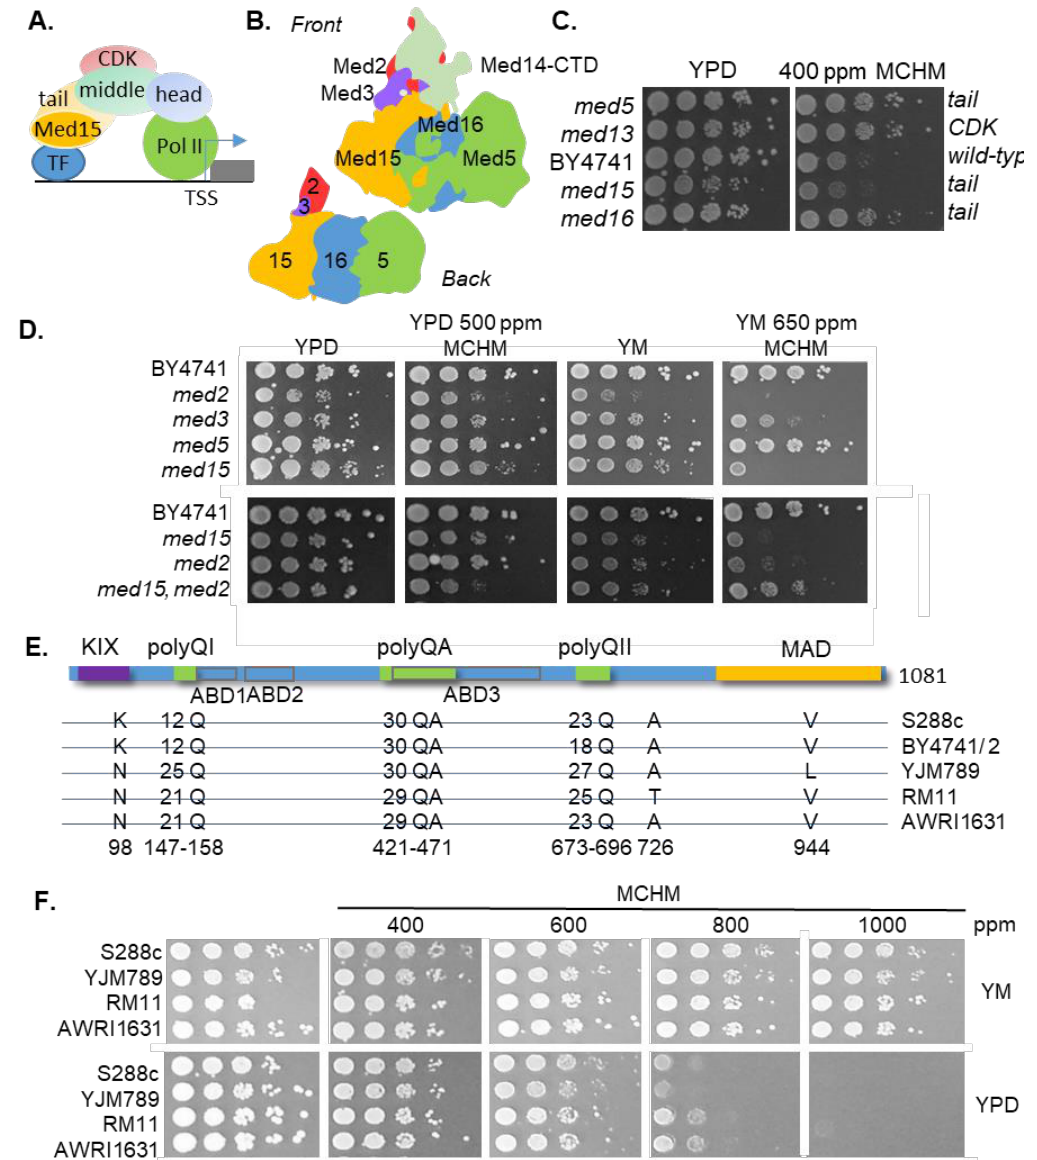
Figure 1. Role of the Mediator tail in response to 4-methylcyclohexane methanol (MCHM). ( A ) Schematic of the Mediator complex. Med15 as part of the tail subcomplex directly interacts with transcription factors (TFs). The middle of the Mediator complex tethers the CDK (cyclin-dependent kinase). The head directly interacts with RNA polymerase II (Pol II) at promoter regions to initiate transcription at transcriptional start sites (TSSs) of genes (gray box). ( B ) Representation of protein components of the Mediator tail based on structures and modeling [3]. Med2 (red), Med14-CTD (light green), Med3 (purple), Med15 (orange), Med16 (blue), and Med5 (green) comprise the tail of the Mediator